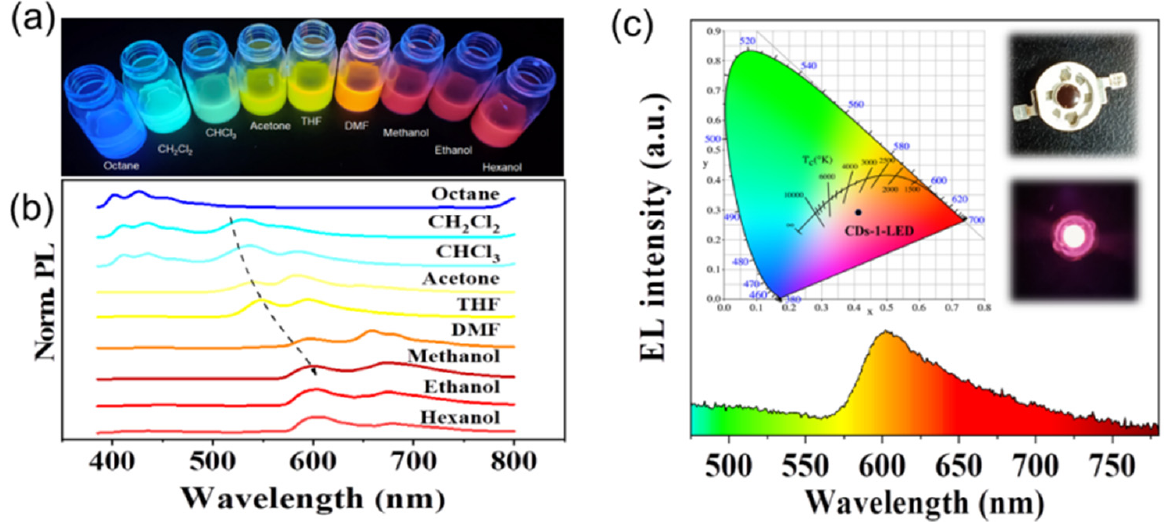
Figure 5. ( a ) Photographs of the same CDs-1 dispersed in nine different solvents and excited with λ = 365 nm UV irradiation. ( b ) The PL emission spectra of the same CDs-1. ( c ) The CIE 1931 containing the color coordinates of the CDs-1–LED device. Inset: The EL emission spectrum of the CDs-1–LED. The insets show optical images of the CDs-1–LED in the “off” (top) and “on” (bottom) states.